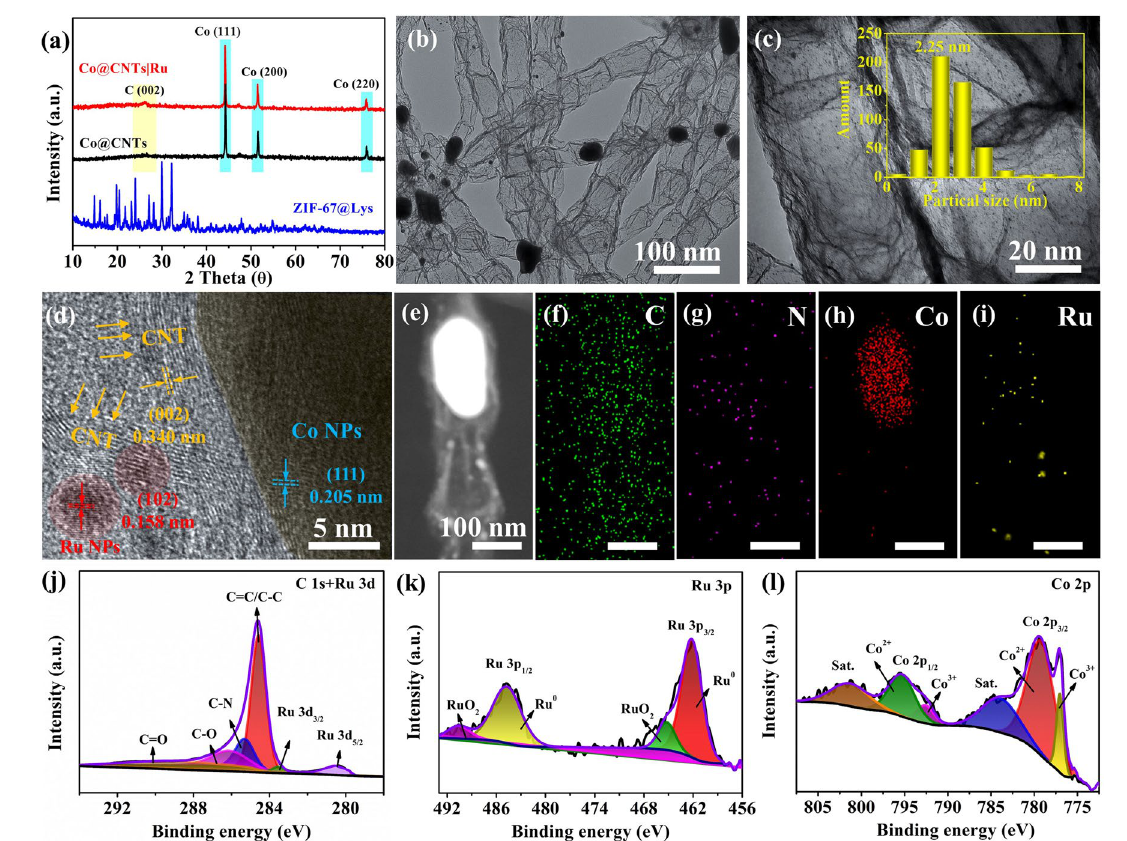
Fig. 2 a XRD patterns of ZIF-67@Lys precursor, Co@CNTs and Co@CNTs|Ru composites; b, c TEM images (Inset c: the particle size distri- bution of Ru nanoclusters), and d HRTEM image of Co@CNTs|Ru composites; e − i HAADF-STEM images and corresponding EDX elemental mappings of Co@CNTs|Ru composites; j − l high-resolution XPS spectrum of C 1 s , Ru 3 p and Co 2 p of Co@CNTs|Ru